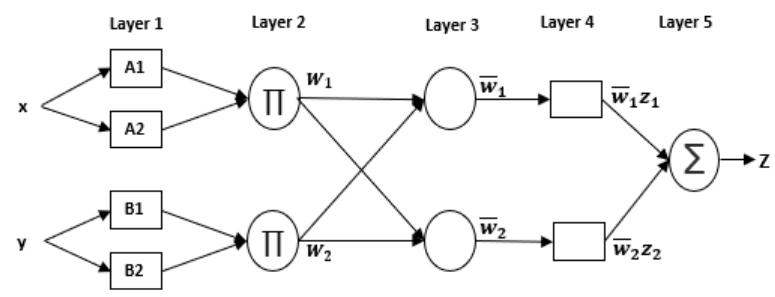
Figure 6. Typical architecture of adaptive neural fuzzy inference system (ANFIS) [54,55].